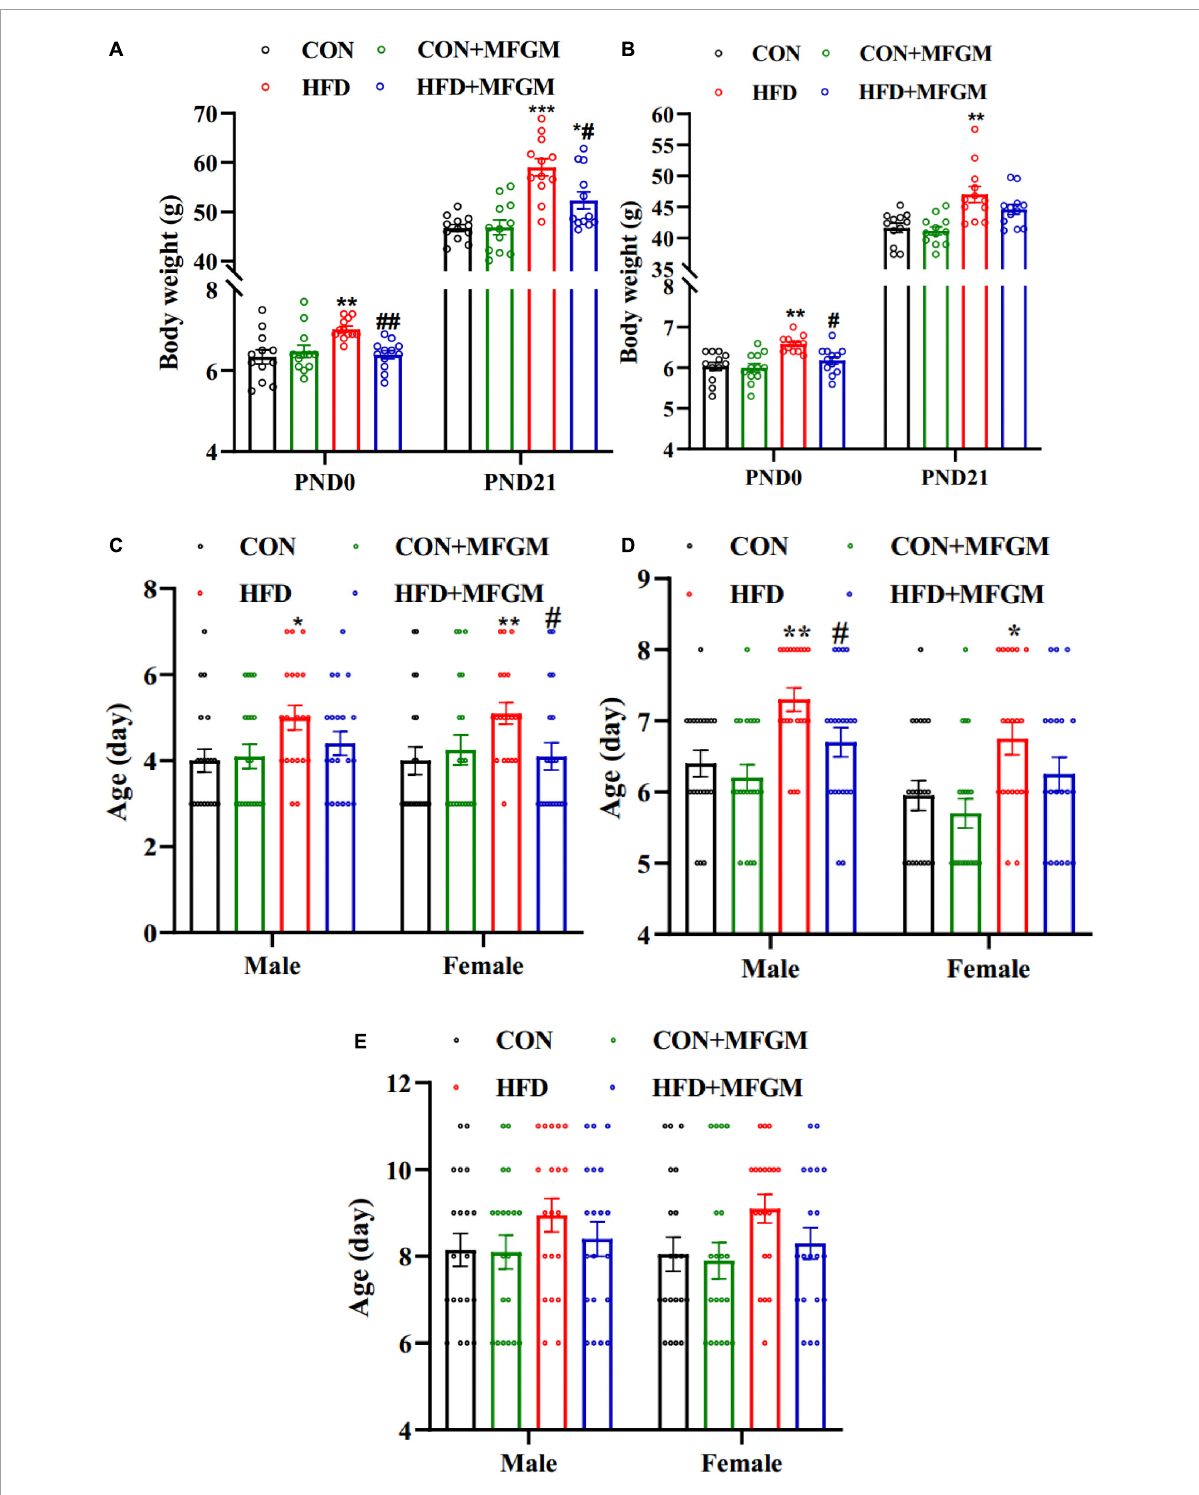
FIGURE1 Maternal supplementation with milk fat globule membrane during pregnancy and lactation promoted neurobehavioral development in offspring from HFD dams before weaning. (A) Body weight of male offspring. (B) Body weight of female offspring, n = 12. The average age of reaching the criterion of right reflex (C) cliff avoidance (D) and negative geotaxis (E) , n = 20. Values are mean ± SEM. * P < 0.05 vs. CON group. # P < 0.05 vs. HFD group. ** P < 0.01 vs. CON group. ## P < 0.01 vs. HFD group. *** P < 0.001 vs. CON